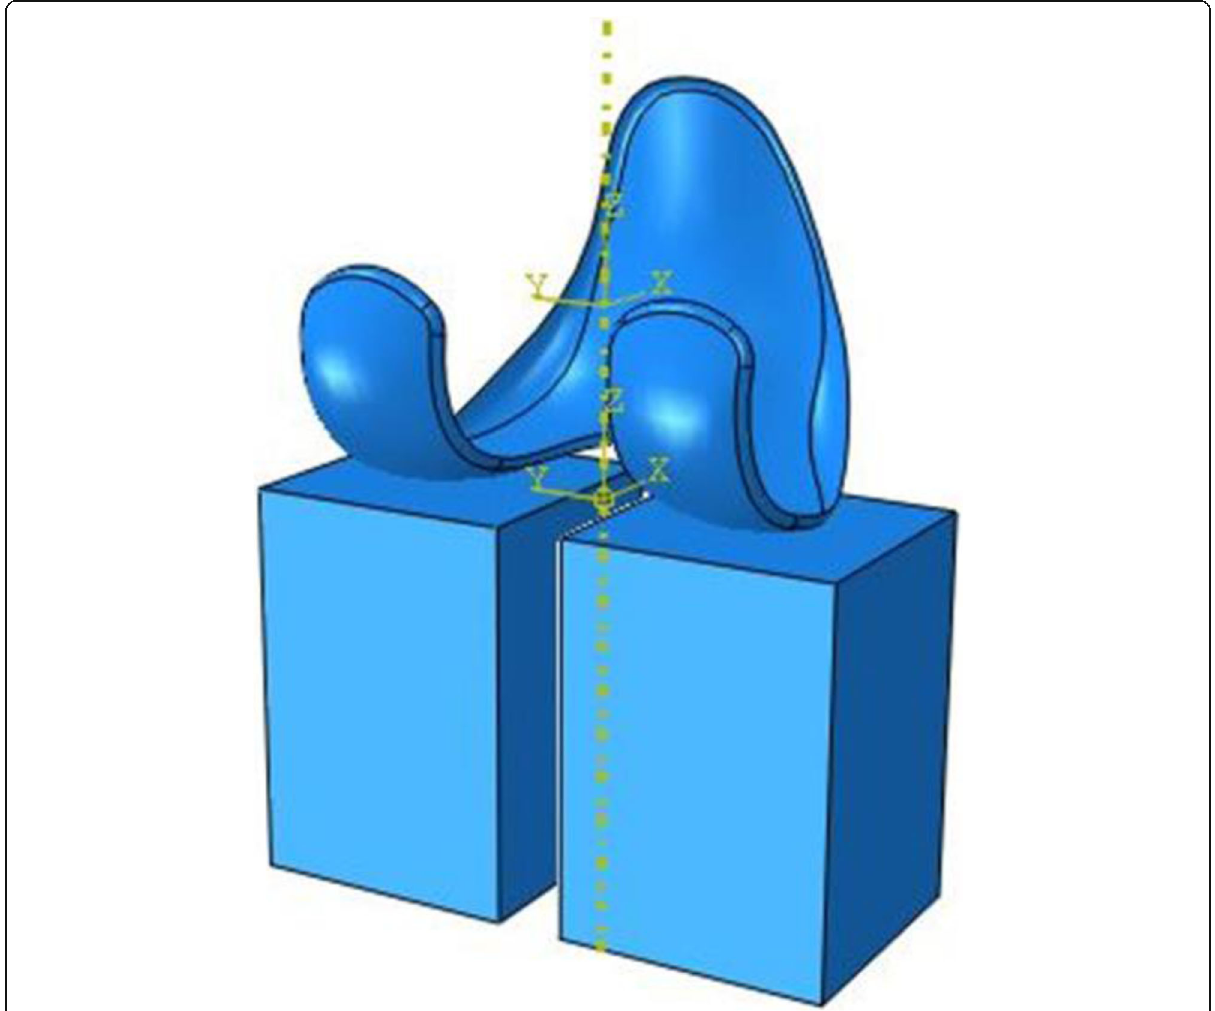
Fig. 2 Initial relative position between the femoral component and the